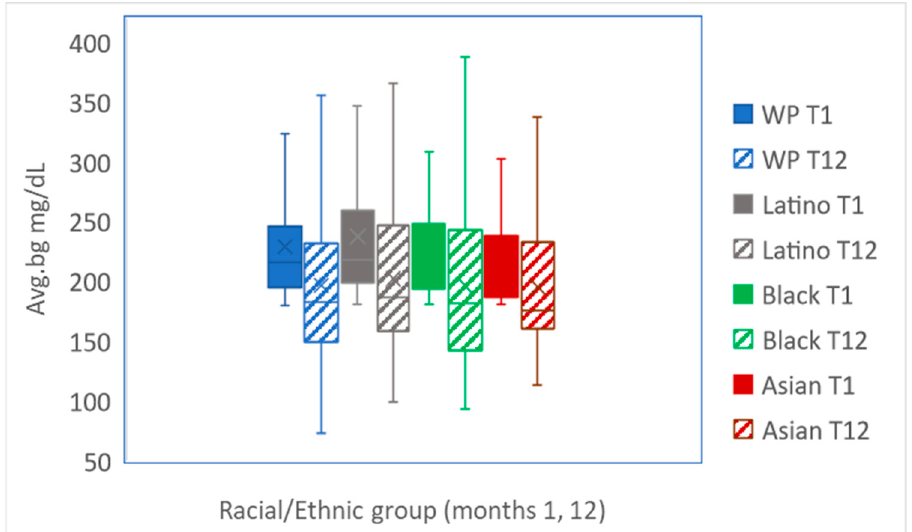
Figure 1. Average blood glucose levels (mg/dL) presentation by ethnic/racial groups. Avg.bg, the average blood glucose levels in T 1 and T 12 are presented per group: WP ( p < 0.001), Latino ( p < 0.001), Black ( p < 0.001), and Asian ( p < 0.005).